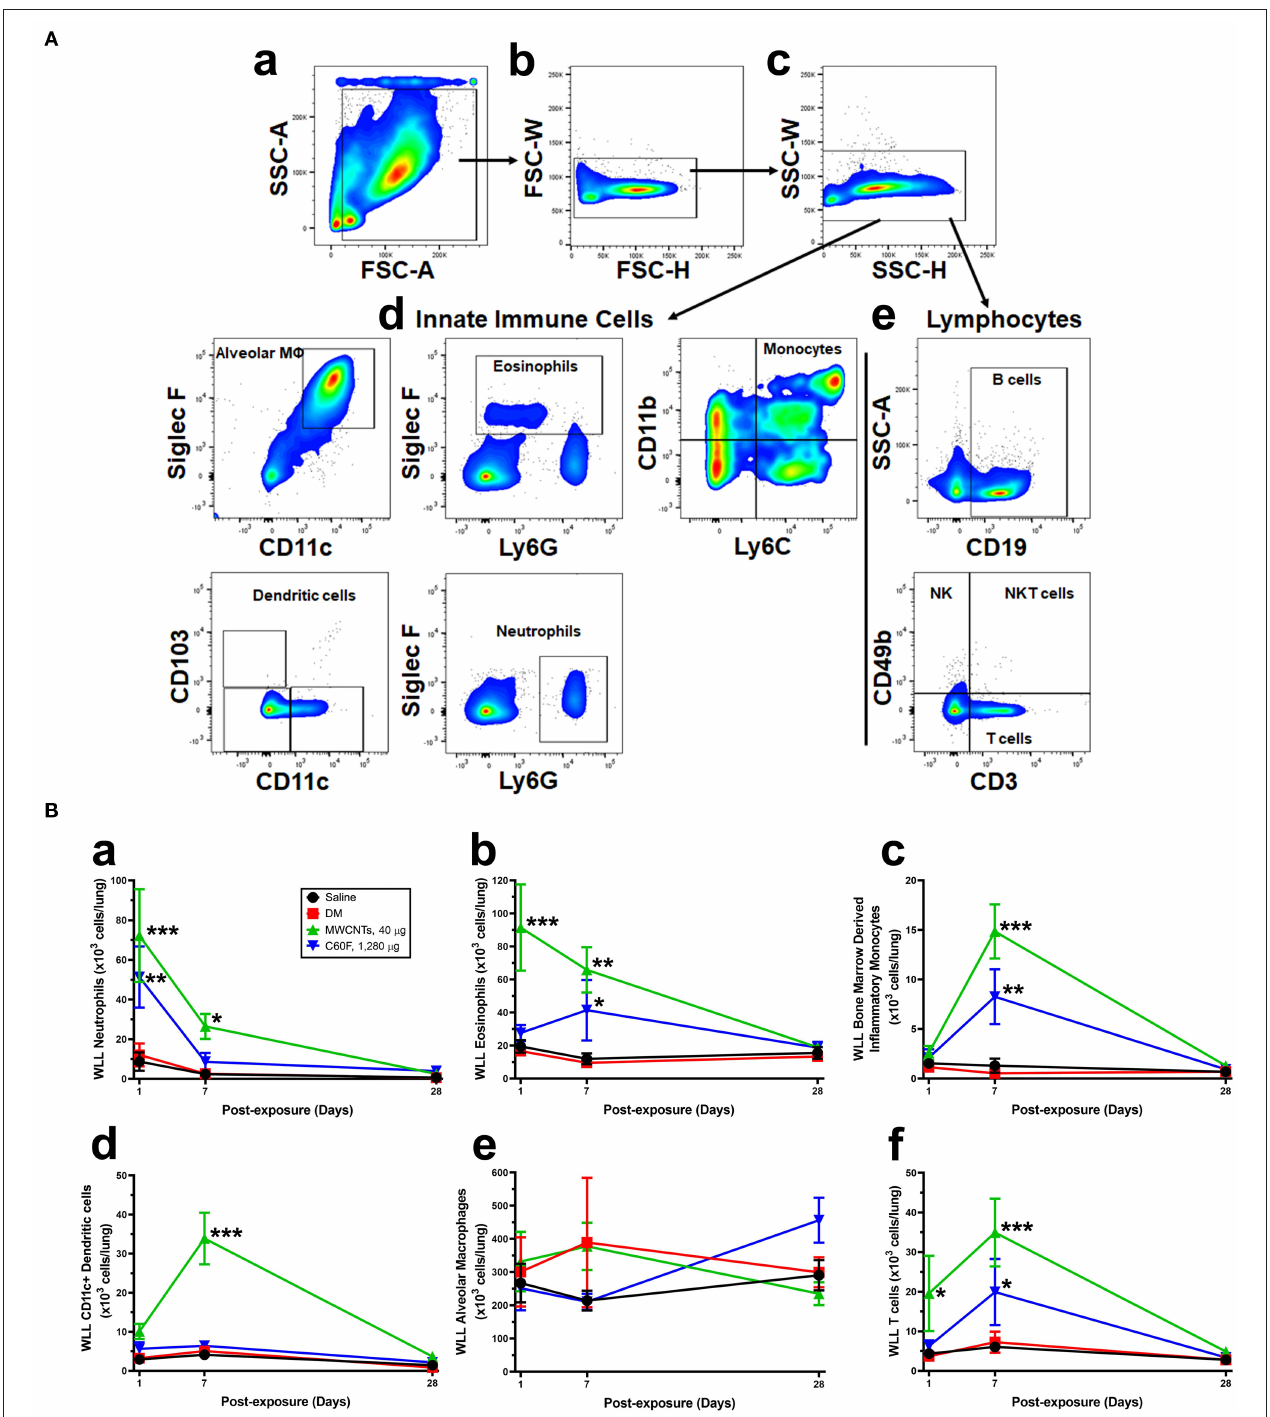
FIGURE 5 | Flow cytometric profiling of immune cells in the mouse WLL fluid. Mice were treated as described in Figure 2 legend and were examined for immune cell profiling of the WLL fluid. (A) Gating strategies. Cells recovered from the mouse WLL fluid were resuspended in 1X PBS, stained with a fluorescent antibody cocktail, fixed, and then used to acquire cell populations using LSR II flow cytometer. Data were further analyzed using FlowJo software. Live cells were discriminated from dead cells, doublets, and debris first using FSC-A vs. SSC-A (a), then gating upon singlet populations in FSC-H vs. FSC-W view (b), then SSC-H vs. SSC-W view (c). Innate immune cells (d) and lymphocytes (e) were further separated. Gating panels were shown to subsequently identify different cell types based on the cell surface markers indicated on the X and Y axes of the flow cytometry pictographs. Cell populations were identified in order as follows: alveolar macrophages, eosinophils, neutrophils, lymphocytes, dendritic cells, and monocytes. (B) Quantification of immune cells. After cell type-specific gating using flow cytometry, neutrophils (a), eosinophils (b), bone marrow-derived inflammatory monocytes (c), CD11c + DCs (d), AMs (e), and T cells (f) were calculated and total cell numbers ( × 10 3 cells/lung) were expressed ( n = 3). * p < 0.05; ** p < 0.01; *** p < 0.001.